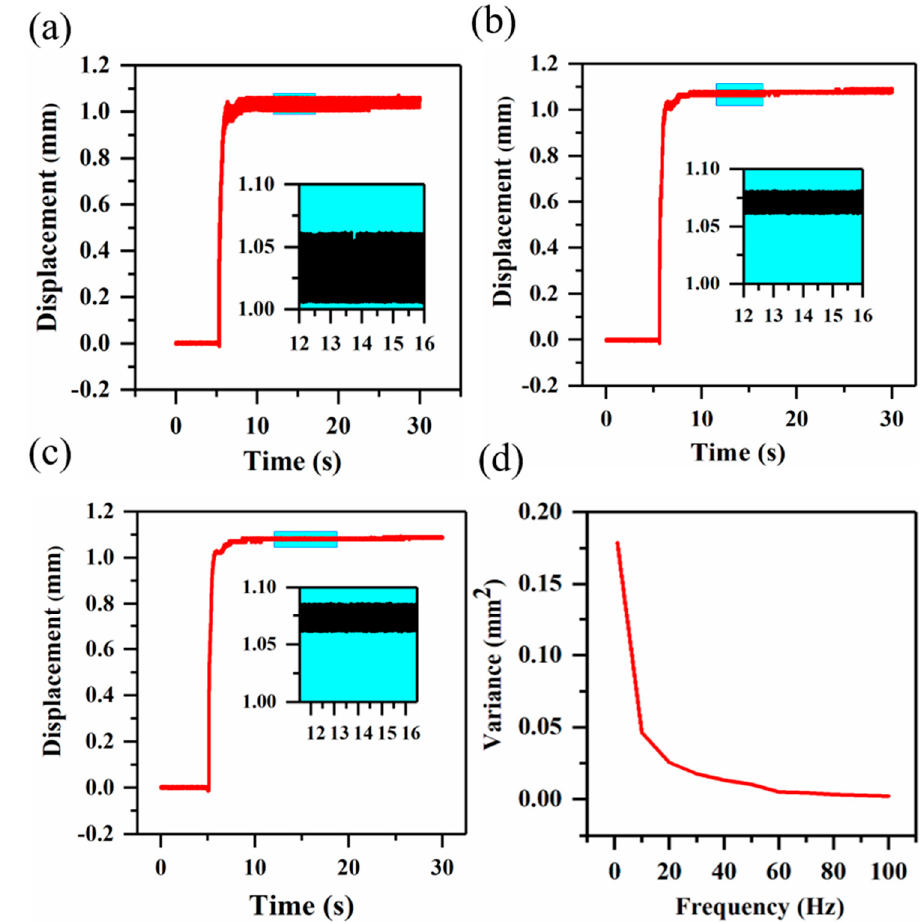
Figure 5. The oscillation of the output displacement of the actuator under the square wave voltage with the same amplitude of 12 kV and di ff erent frequencies of ( a ) 10 Hz, ( b ) 50 Hz, ( c ) 100 Hz, respectively. ( d ) The variance of the output displacement of the actuator under a square wave voltage (12 kV) with di ff erent frequencies (1–100 Hz).